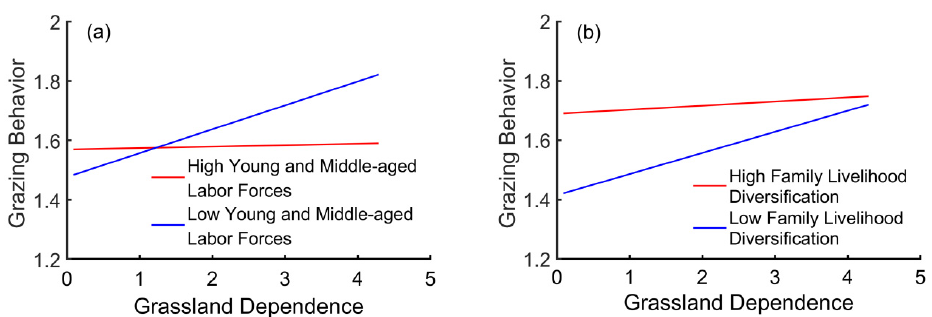
Figure 5. ( a ) Moderating effects of young and middle-aged laborers on grassland dependence and grazing behavior; ( b ) Moderating effects of family livelihood diversity on grassland dependence and grazing behavior.